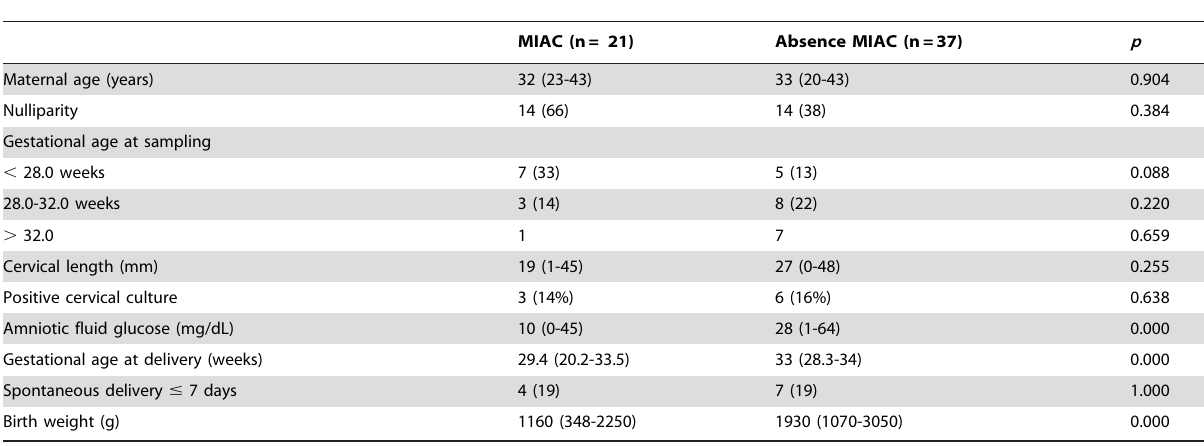
Table 1. Maternal characteristics according to MIAC in women with